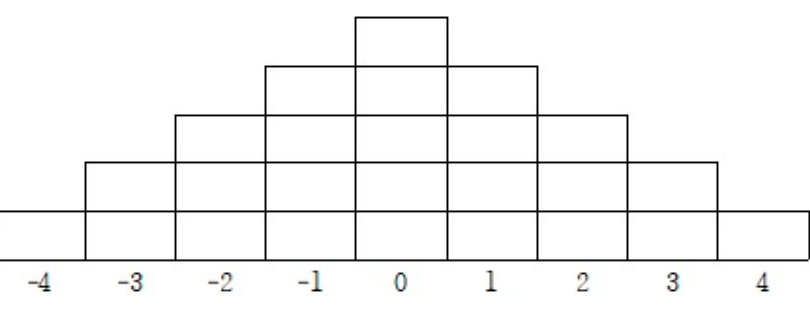
Figure 1. Q sorting response table.